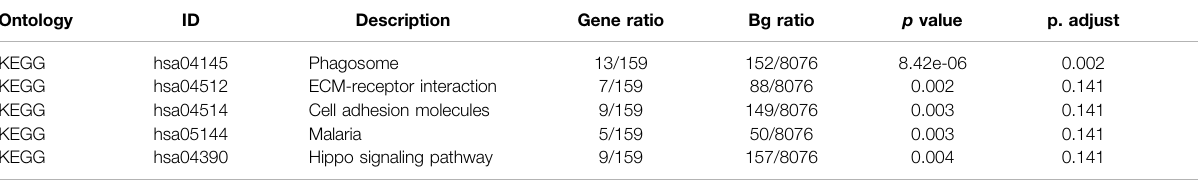
TABLE 2 | KEGG enrichment analysis of